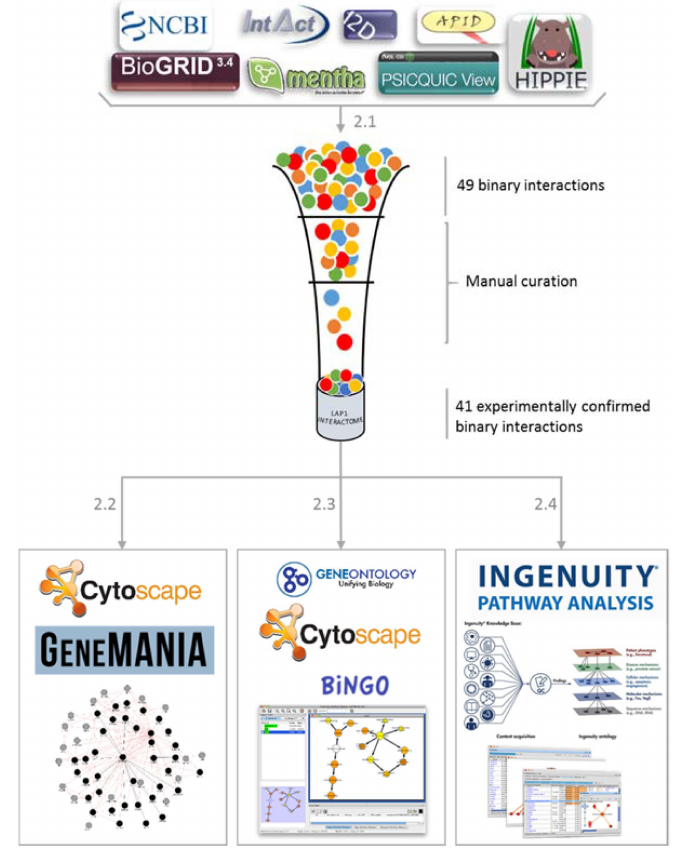
Figure 1. Methods overview. Schematic representation of the workflow; the steps necessary to integrate the Network of LAP1 integrators are